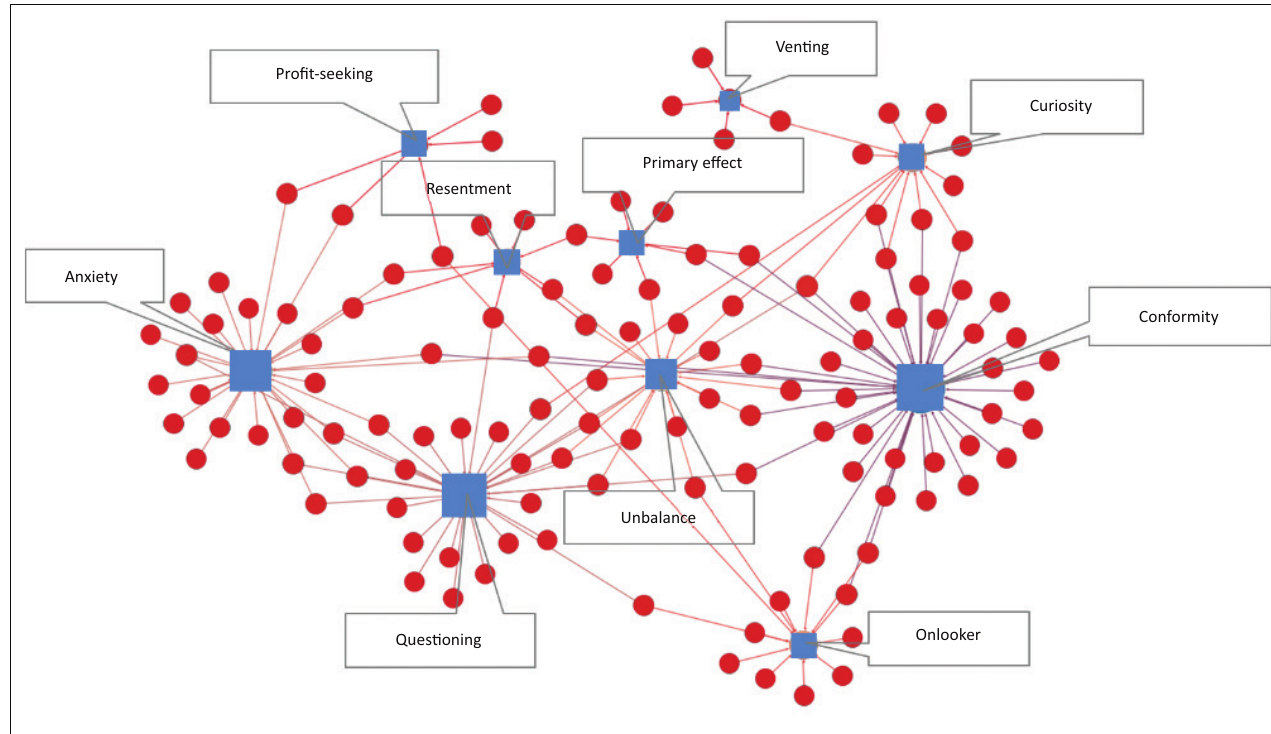
FIGURE 9: Network of psychological characteristics of